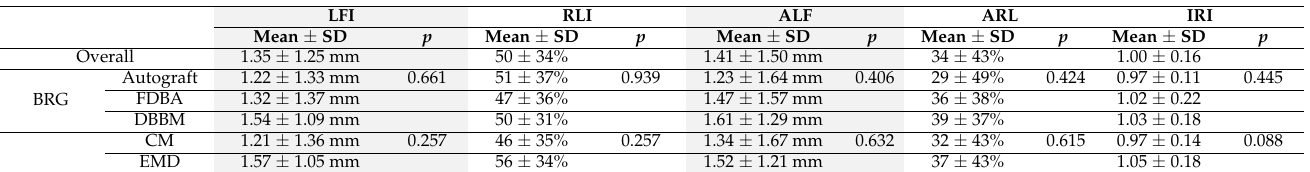
Table 4. The outcome of FDR in the combined furcation-angular defect group based on treatment strategies . LFI Overall